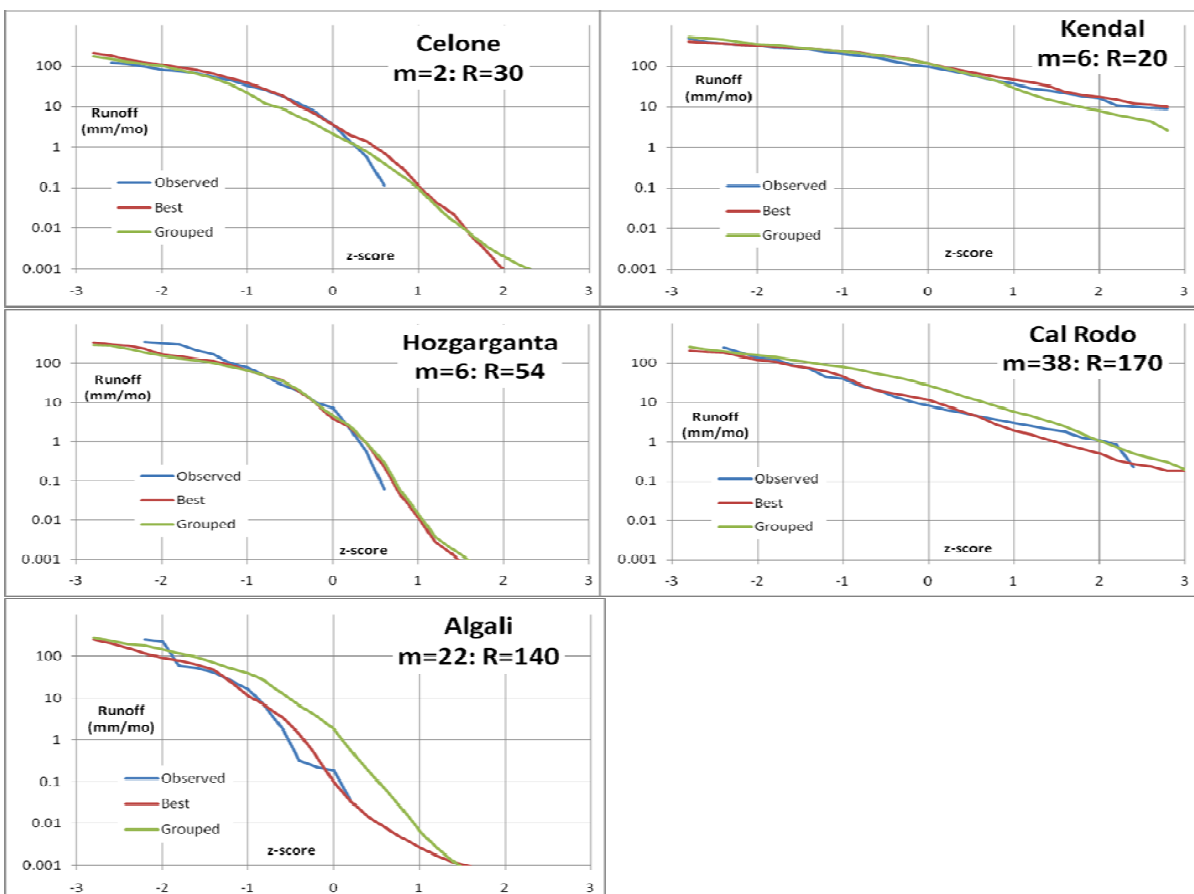
Figure 4. Exceedance curves for the five test catchments. Each graph shows the observed Fig. 3. Flow duration curves for the five test catchments. Each graph shows the observed data, the individual best fit model and the grouped best fit model. R and m refer to TOPModel data, the individual best fit model and the global best fit model